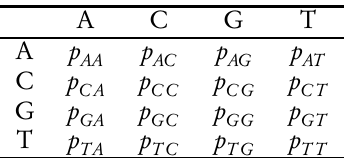
Substitution probability